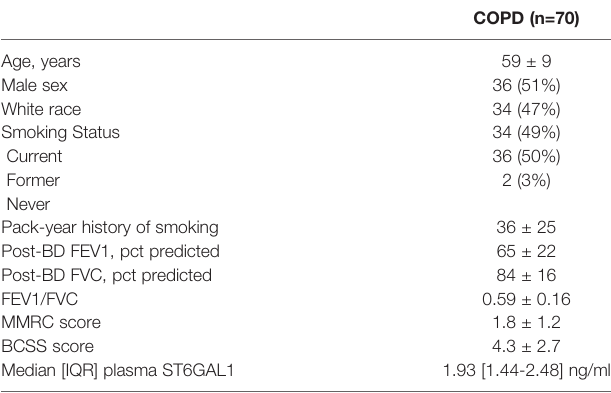
TABLE 1 | Baseline